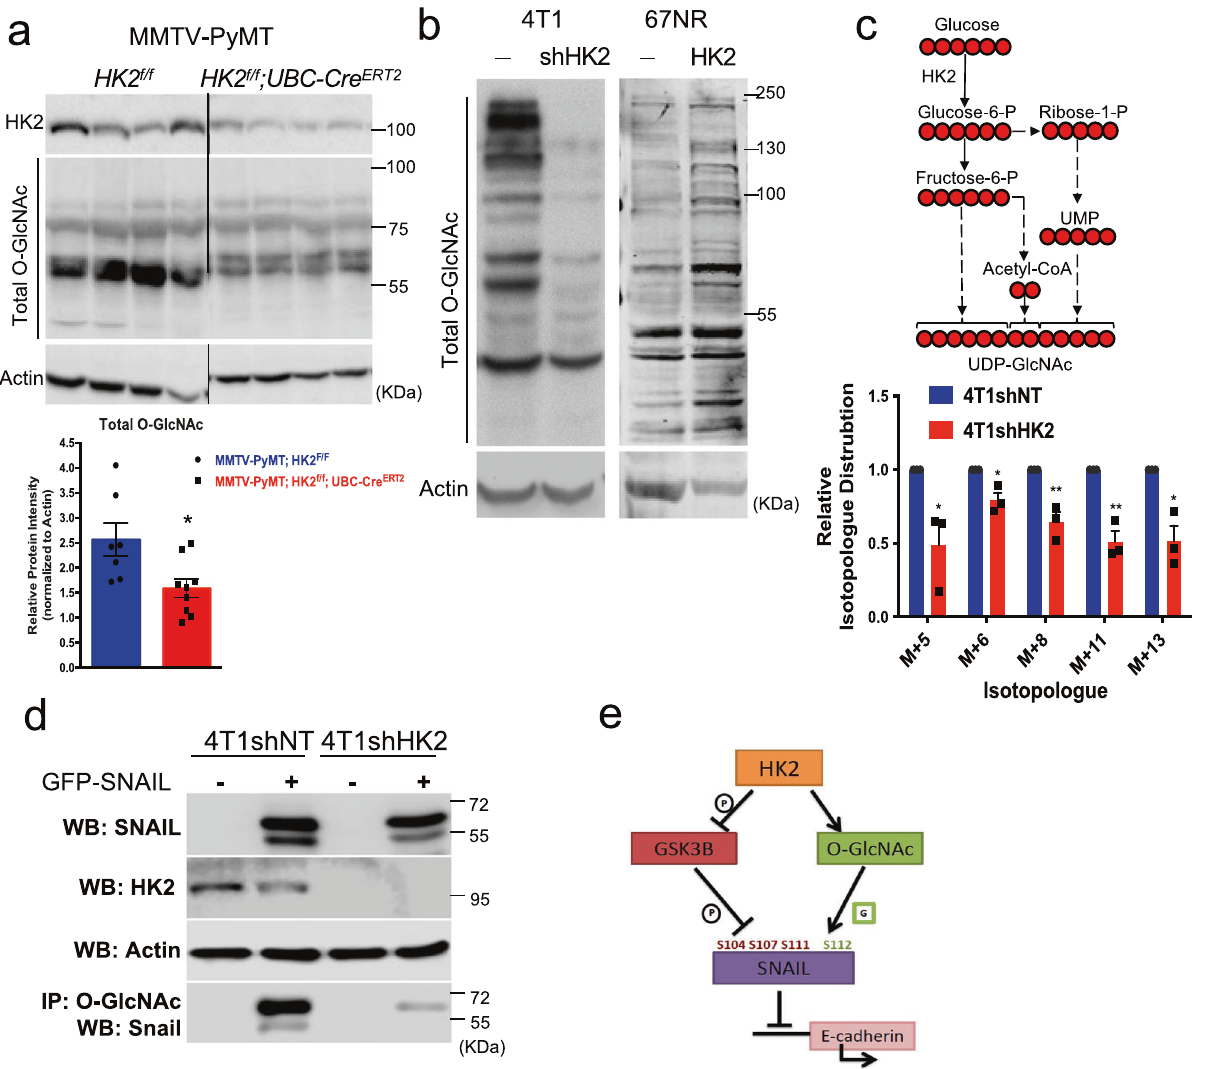
Fig. 10 HK2 de fi ciency inhibits the incorporation of metabolically labeled glucose into UDP-N-acetylglucosamine and reduces total and SNAIL O-GlcNAc modi fi cation. a Left: representative immunoblot images showing total O-GlcNAc protein modi fi cation in MMTV-PyMT mammary gland tumors after systemic deletion of HK2. Right: quanti fi cation of total O-GlcNAc modi fi cations in control primary tumors ( n = 7 tumors from three mice) and primary tumors after systemic HK2 deletion ( n = 9 tumors from six mice). Results are the mean ± SEM; * p = 0.016 using unpaired two-tailed t -test. b Immunoblot images of total O-GlcNAc protein modi fi cation in 4T1 cells after HK2 silencing and 67NR cells after HK2 overexpression (representative of two immunoblots from two independent experiments). c Tracing of UDP-GlcNAc isotopomers after culturing 4T1 and 4T1shHK2 cells with 5 mM of U 13 C 6 - glucose for 5 min. Tracing was performed by ion chromatography (IC-MS). Data shown as fold-changes relative to the control 4T1shNT cells for each isotopomer for UDP-GlcNAc with natural abundance correction and represented as the mean ± SEM. * p < 0.05, ** p < 0.01 ( M + 5 p = 0.03, M + 6 p = 0.015, M + 8 p = 0.005, M + 11 p = 0.0023, M + 13 p = 0.01) from triplicate experiments using two-tailed t -test ( n = 3). The schematic shows the contribution U 13 C 6 -glucose-6-P to the UDP-GlcNAc isotopomers. d Immunoprecipitation with anti-O-GlcNAc and immunoblotting with anti-SNAIL after transient transfection of 4T1 and 4T1shHK2 cells with GFP-SNAIL (representative of two independent experiments). e Schematic depicting how HK2 affects SNAIL protein stability and activity. Uncropped blots are provided as a Supplementary Fig. 16. Source data are provided as a Source Data fi